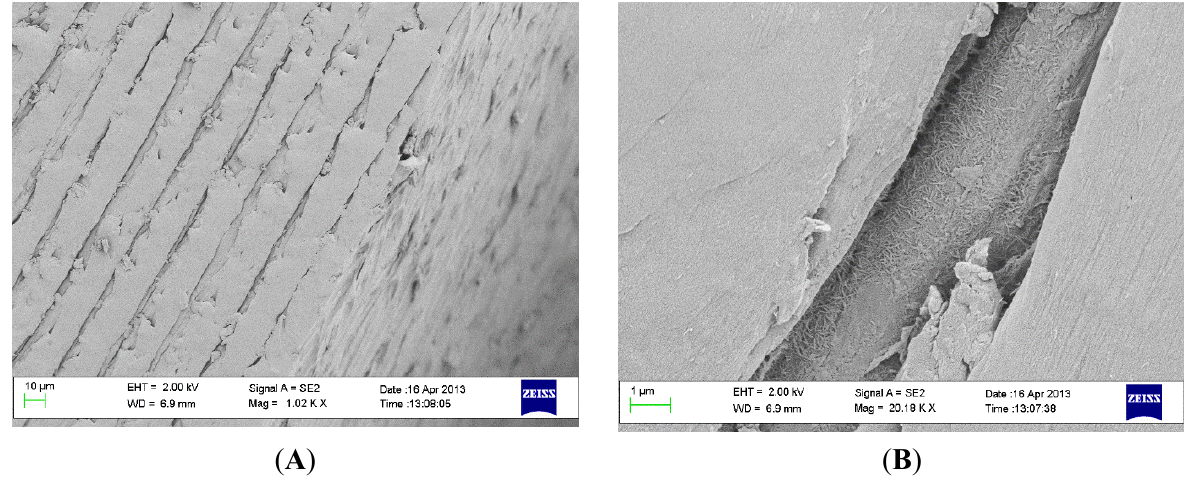
Figure 3. SEM images of thread edge of implant after insertion and removal. ( A ) scale bar = 10 µm and ( B ) scale bar = 1